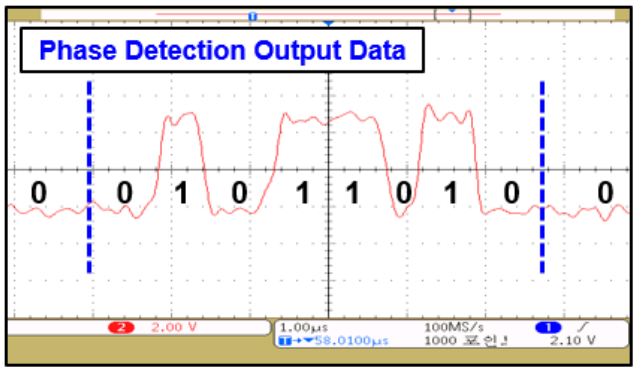
Figure 17. Measured output data of phase detection path (The meaning of the Korean is the same as